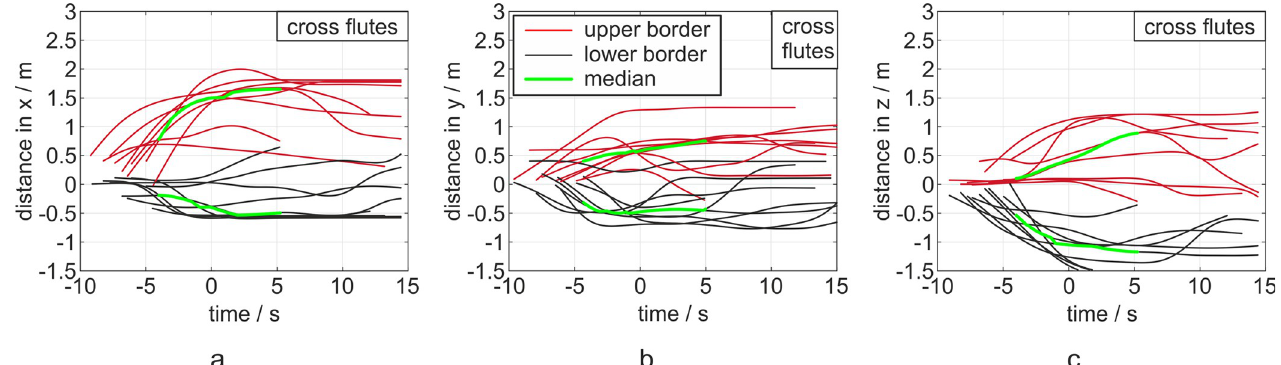
Fig 5. Diagrams of distances in x-, y- and z-direction (a, b, c) from left to right for the flutes. The 0 point in the time-scale refers to the end of the task. Each task is represented by a red (upper border) and a black curve (lower border) indicating the maximum distances of the cloud in the respective directions. The median devolution in both directions is shown in green. The corresponding diagrams with color-coded notation of the three tasks are displayed in the S2 Fig.